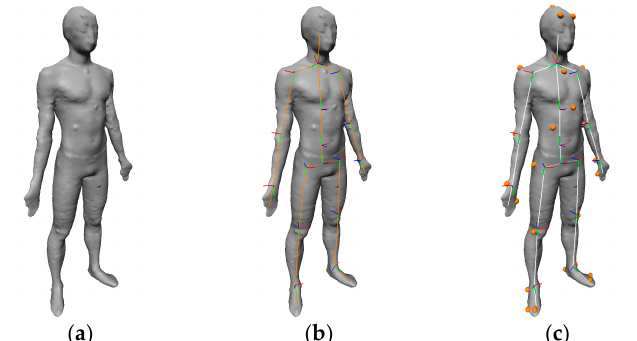
Figure 2. Process of individual model construction. ( a ) Import body shape data; ( b ) construct link segment model; ( c ) added feature points at the same positions as used for underwater motion-capture